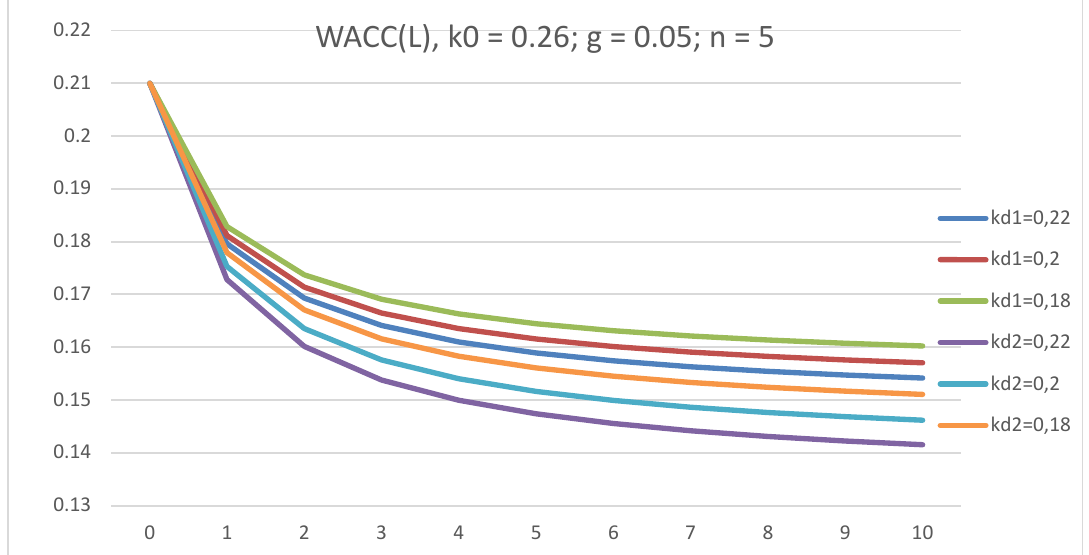
Figure 5. The dependence of WACC on leverage level, L, in GBFO theory with payments of tax on profit at the end of periods (1) and advance payments (2) at k 0 = 0.26; k d = 0.22; 0.2; 0.18 t = 0.2; g = 0.05, for a five-year company.